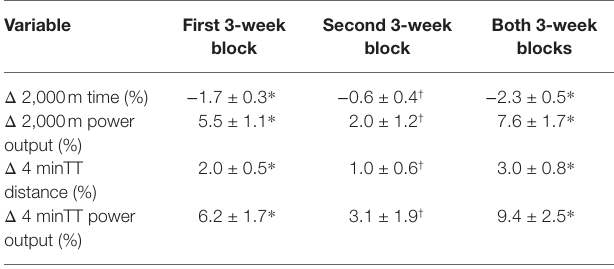
TABLE 3 | Change in performance measures following the first training block (BLOCK1) and the second training block (BLOCK2).